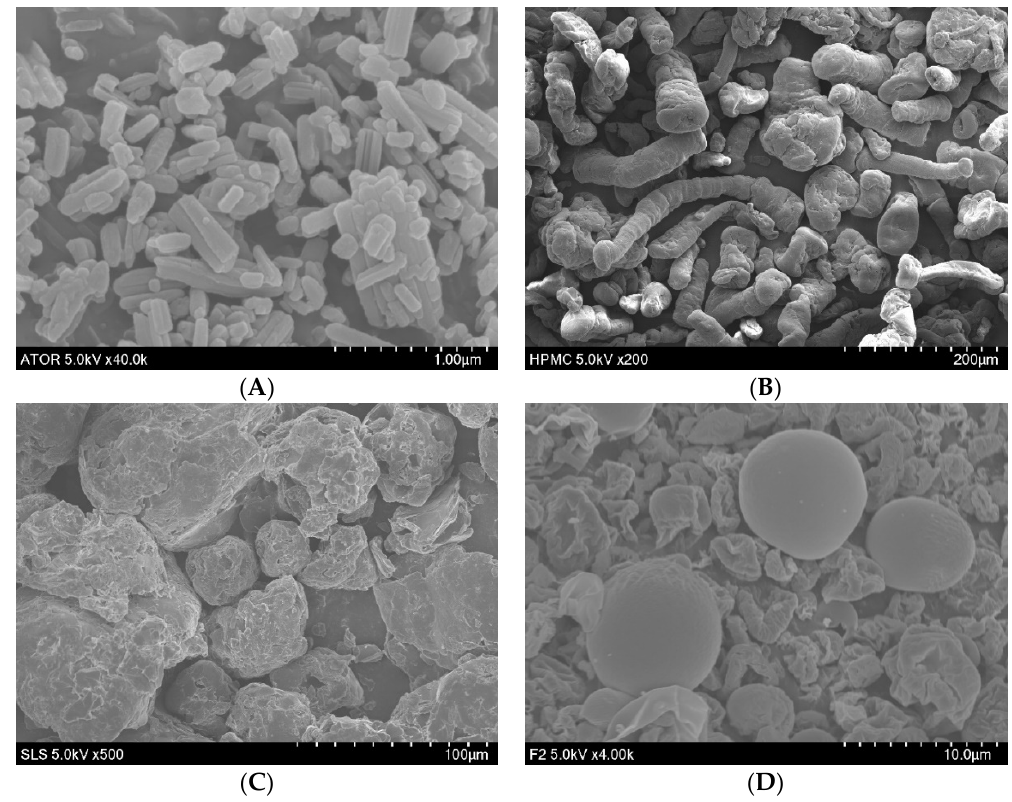
Figure 4. SEM images of ( A ) free ATO (40,000 X), ( B ) HPMC (200 X), ( C ) SLS (500 X), and ( D ) F2 (4000 X).